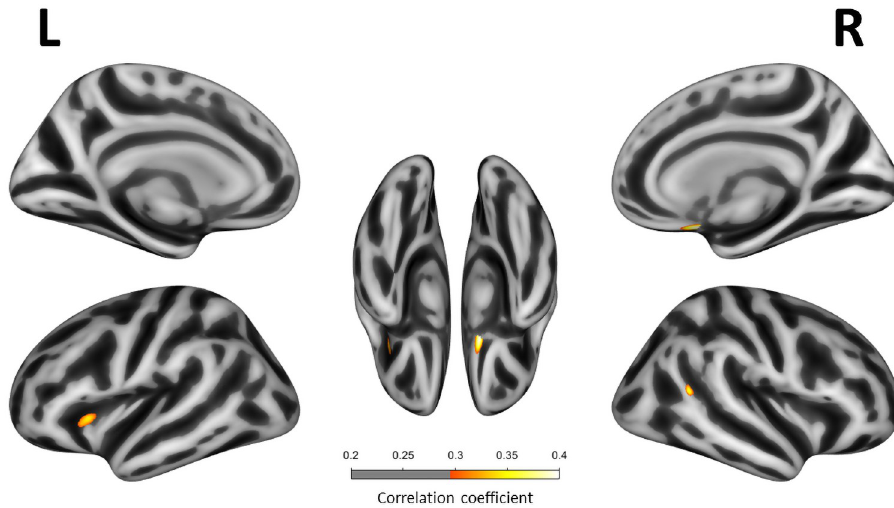
Fig 3. Correlation between Insomnia Severity Index scores and cortical thickness adjusting by Geriatric Depression Scale. Correlation between ISI scores and cortical thickness in all participants (n = 119). Only regions with P -value < .001 (uncorrected FWE) are shown. All multivariate linear regression models were adjusted for age, sex, handiness and scan type and Geriatric Depression Scale. Correlation coefficients are expressed as a color scale, indicating an increasing strength of the correlation from red to yellow.